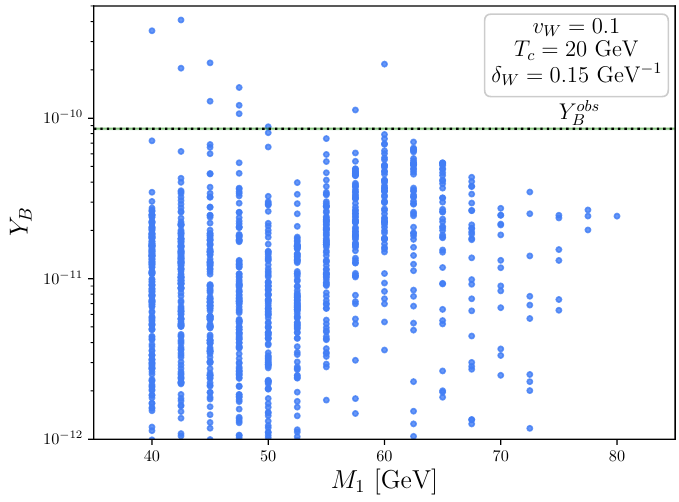
Figure 8 . Generated baryon asymmetry if the invisible decay of the Z boson does not apply to the bounds on neutrino mixing. In this case the singlet neutrinos need to be lighter than the Z , favoring lower temperatures for the phase transition. The di(cid:11)erent mass ranges are M 1